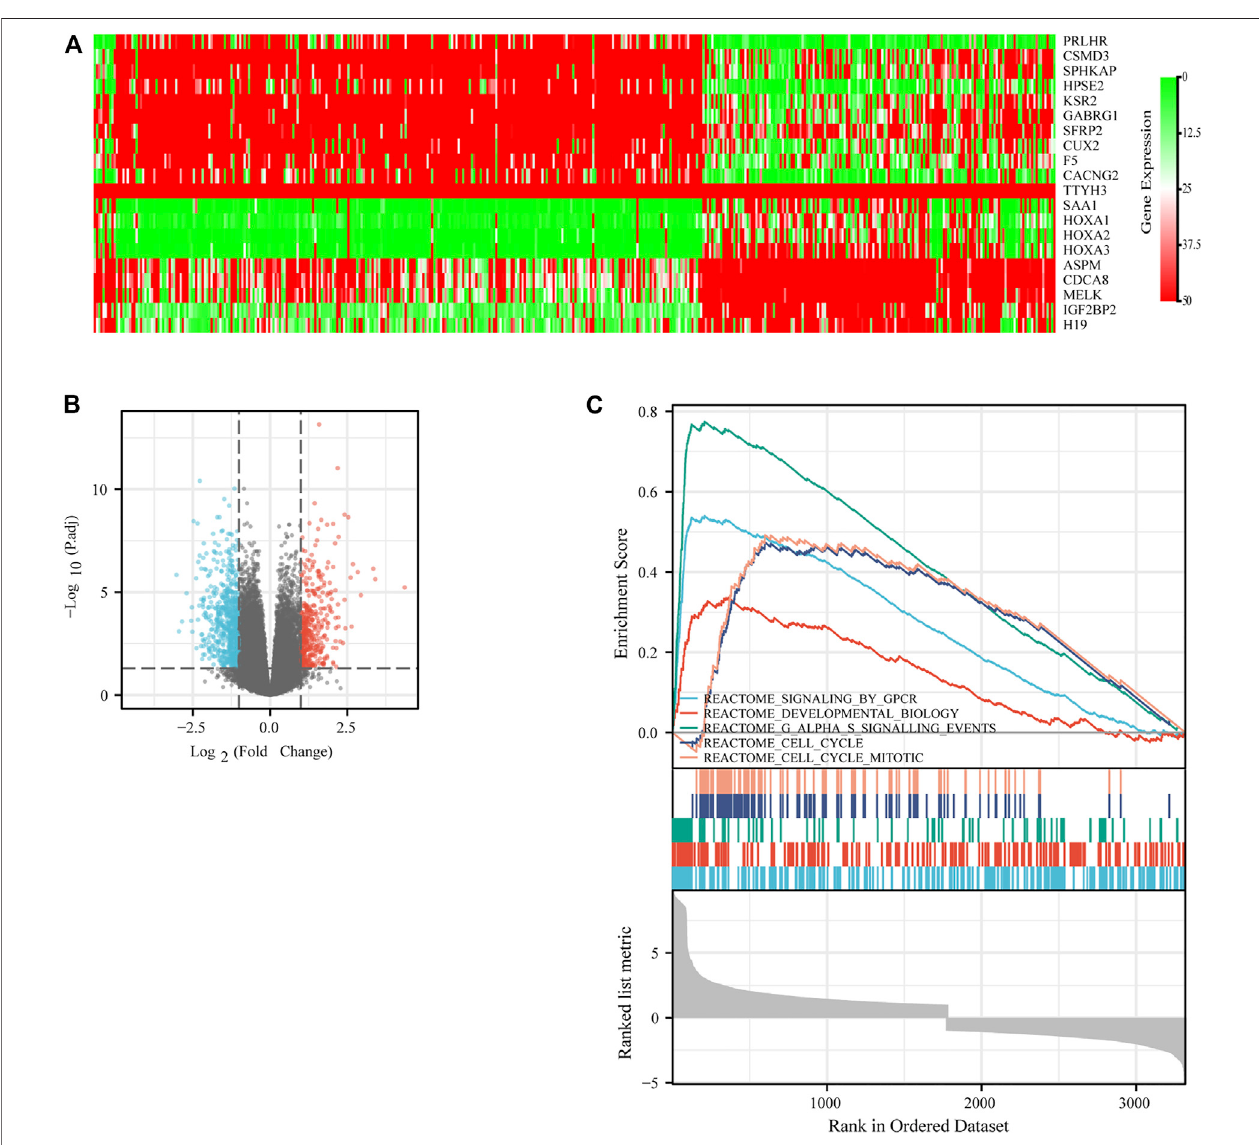
FIGURE 8 | Differentially expressed genes (DEGs) related to IGF2BP3 in gliomas. (A) Heatmap of the DEGs. Red scattered dots indicate highly expressed DEGs with the adjusted p value < 0.05, and green ones indicated low expressed DEGs with the adjusted p value < 0.05. (B) Volcano plot of the DEGs. (C) Top fi ve signi fi cant cellular processes and pathways in GSEA